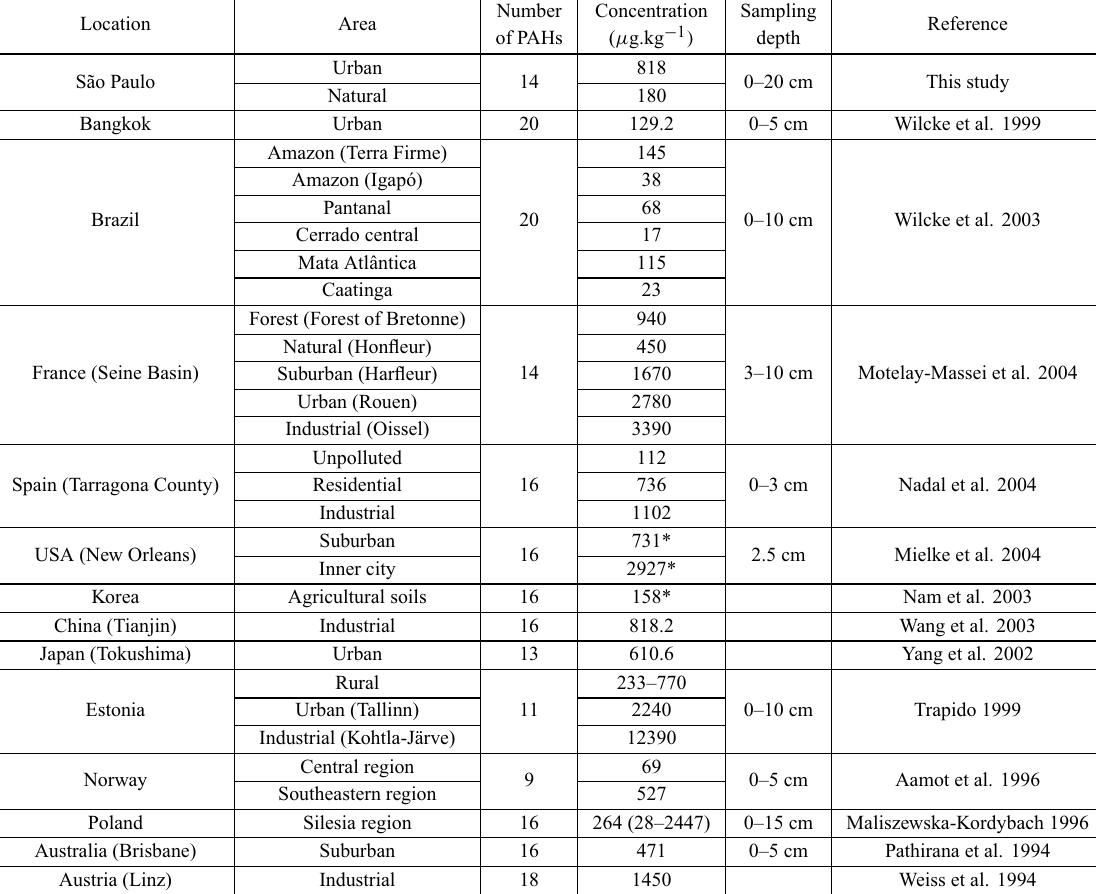
(cid:1) (cid:2) in µ g.kg –1 in other countries of the world